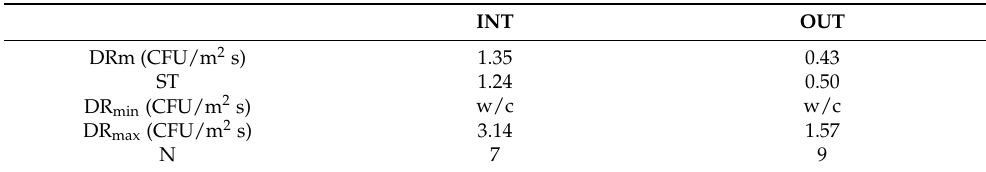
Table 5. Total mean E. coli deposition rate (DRm, CFU/m 2 s) standard deviation (ST), minimum E. coli deposition rate (DR min , CFU/m 2 s), maximum E. coli deposition rate (DR max , CFU/m 2 s), number of samples (N). Sampling date: 5 April 2022, sampling site: withing the pens (INT), around the pens (OUT). w/c: saturated Petri dishes without